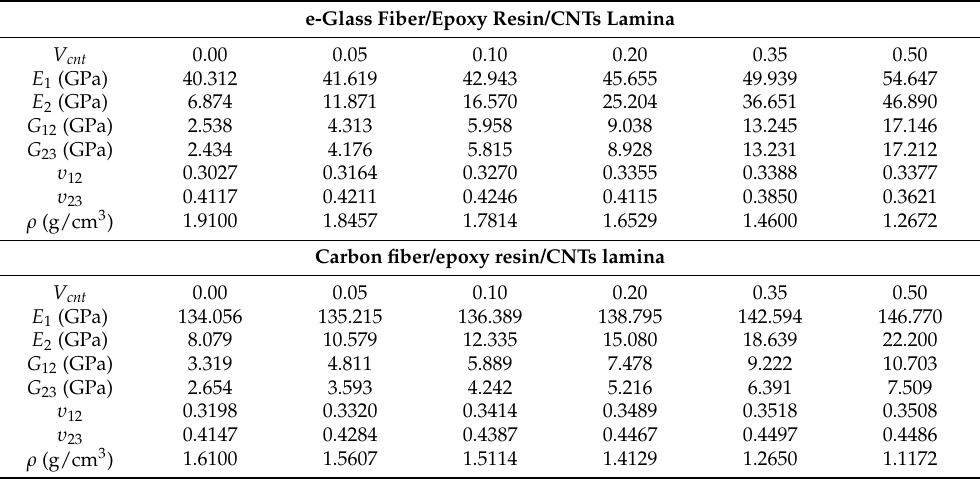
Table 2. Material properties of unidirectional composite